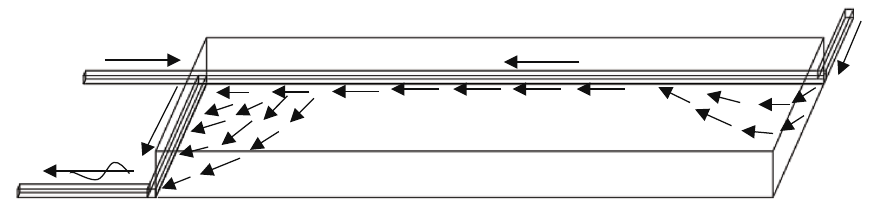
Figure 7: Track chart of air leakage air fl ow in the goaf.